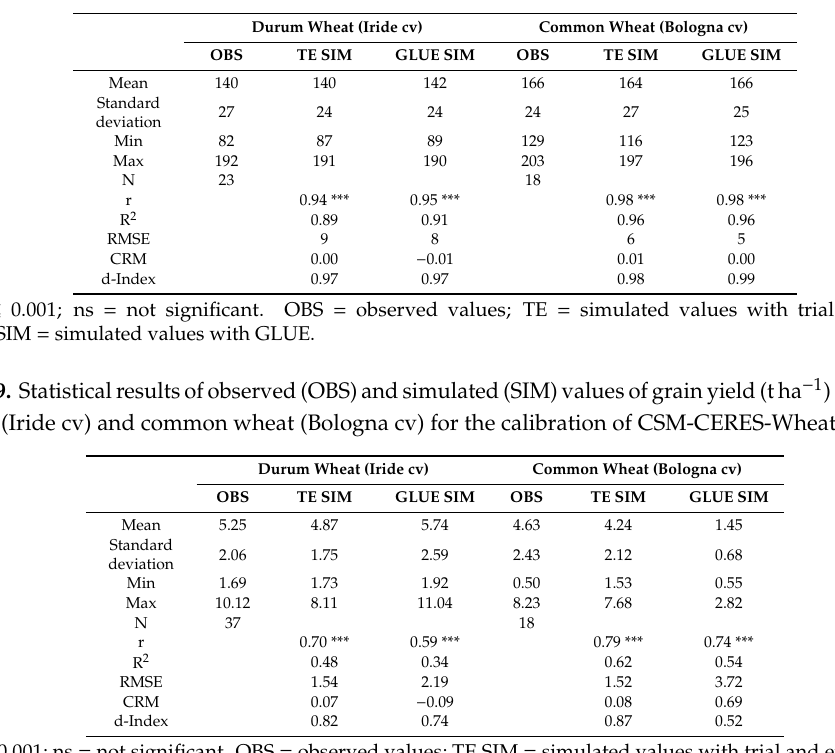
Table 8. Statistical results of observed (OBS) and simulated (SIM) values of anthesis date (in days after planting = dap) for durum wheat (Iride cv) and common wheat (Bologna cv) for the calibration of CSM-CERES-Wheat model.